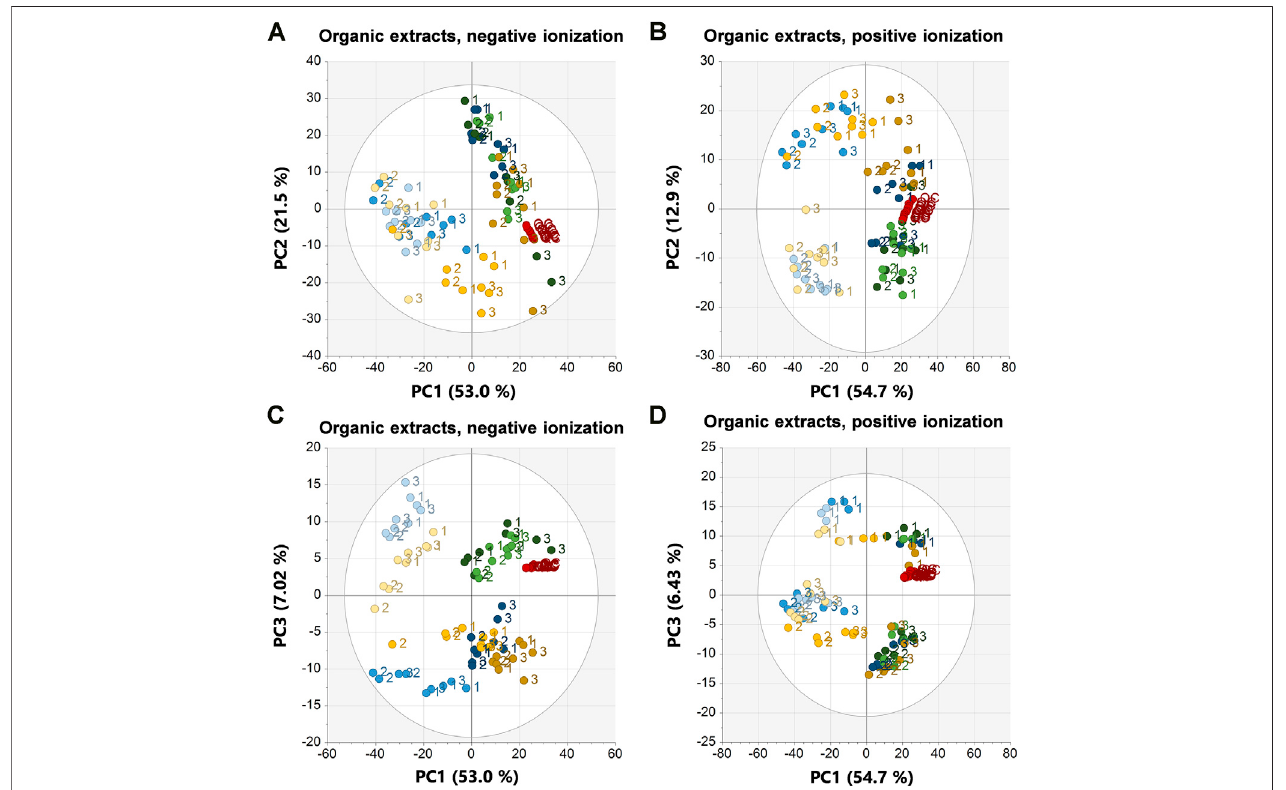
FIGURE4| PCAscoresplotsoftheorganicextractsinnegativeionization(R2X (cid:2) 0.958,Q2 (cid:2) 0.912)totheleftandpositiveionization(R2X (cid:2) 0.937,Q2 (cid:2) 0.887)to the right. (A) PC1 vs. PC2 in negative ionization, (B) PC1 vs. PC2 in positive ionization, (C) PC1 vs. PC3 in negative ionization, (D) PC1 vs. PC3 in positive ionization. Labelsdenotethespecimenid:s1,2,and3.EtOHextr.1(darkblue ),EtOHextr.2(blue ),EtOHsp.(lightblue ),MeOHextr.1(darkorange ),MeOHextr.2(yellow ), MeOH sp. (light yellow ), frozen (dark green ) and fl ash frozen (green ), and QC-samples (red